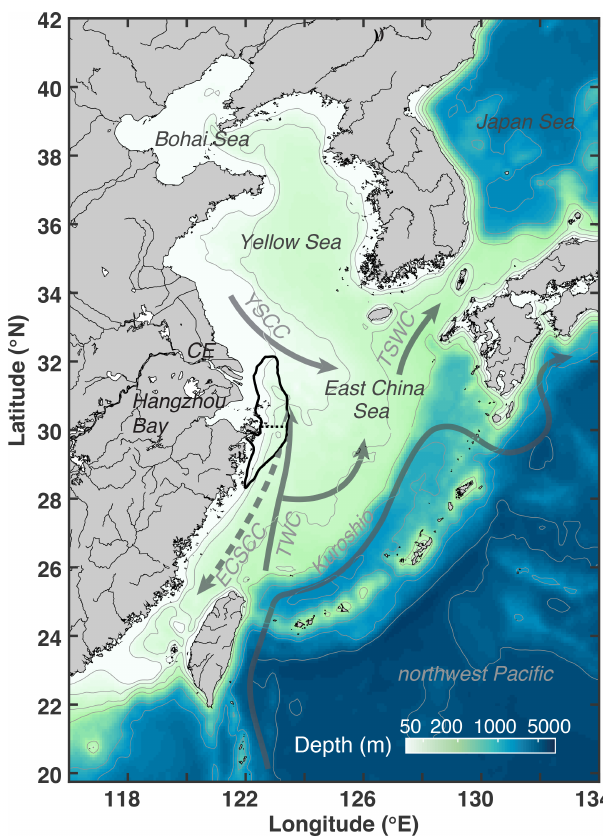
Figure 1. Bathymetry of the model domain with 30, 50, 100, 200, 1000, 2000, and 5000m isobaths. The black outline near the Changjiang Estuary (CE) and Hangzhou Bay indicates the zone typ- ically affected by low-oxygen conditions (dotted line shows sep- aration between northern and southern zones). Solid grey arrows denote currents present throughout the year (Kuroshio; TWC: Tai- wan Warm Current; YSCC: Yellow Sea Coastal Current; TSWC: Tsushima Warm Current). The dashed grey arrow indicates the di- rection of the wintertime East China Sea Coastal Current (ECSCC), which flows in the opposite direction in